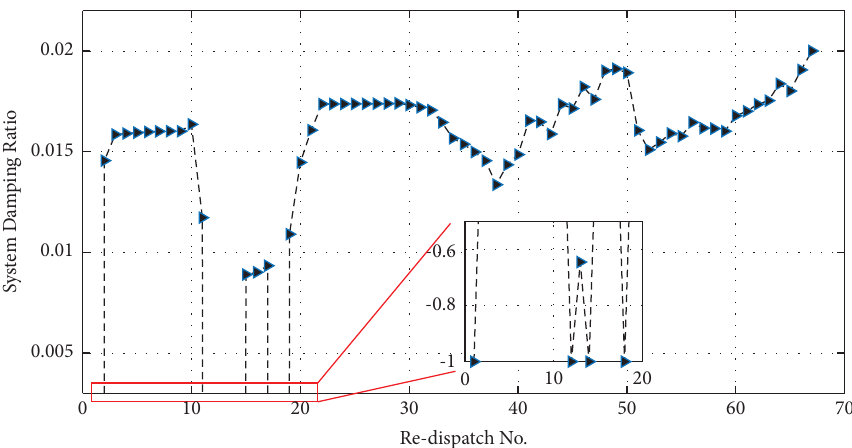
Figure 13: Trace of system damping ratio for IEEE 118-bus